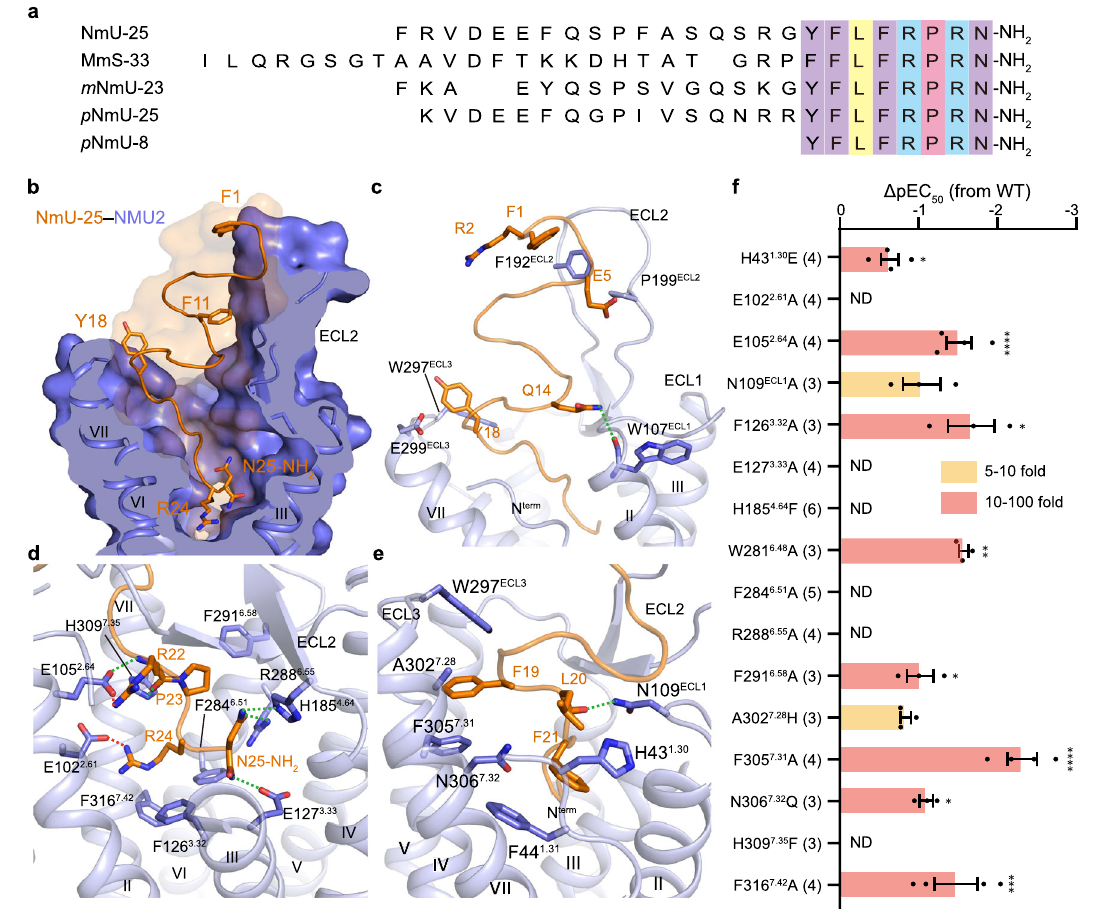
Fig. 2 | Overall NmU-25 binding mode in NMU2. a Sequence alignment of NmU peptides from different species. Alignment was carried out by align tool in the UniProt database (https://www.uniprot.org/). The UniProt ID of NmU-25, NmS-33, m NmU-23 and p NmU-25/8 are P48645, Q5H8A3, Q9QXK8, and P34964, respec- tively. The conserved C-terminal heptapeptide is indicated by colorful square frames. b The cutting face of the ligand binding pocket in the NmU-25 – bound NMU2 structure. NmU-25 is represented as orange sticks and cartoons with trans- parent surfaces. NMU2 is shown as a slate cartoon with a light blue surface. c Interactions between the N-terminal segment of NmU-25 and the NMU2. The residues of the receptor and the ligand are shown as slate and orange sticks. A hydrogen bond is indicated by a green dash line. d Close view of the interactions